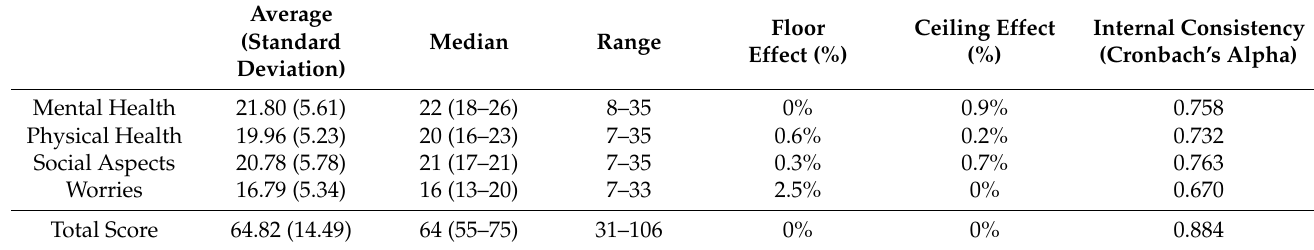
Table 2. Description, responsiveness, and internal consistency of the instrument and factors of ASDPCA-QoL ( n =